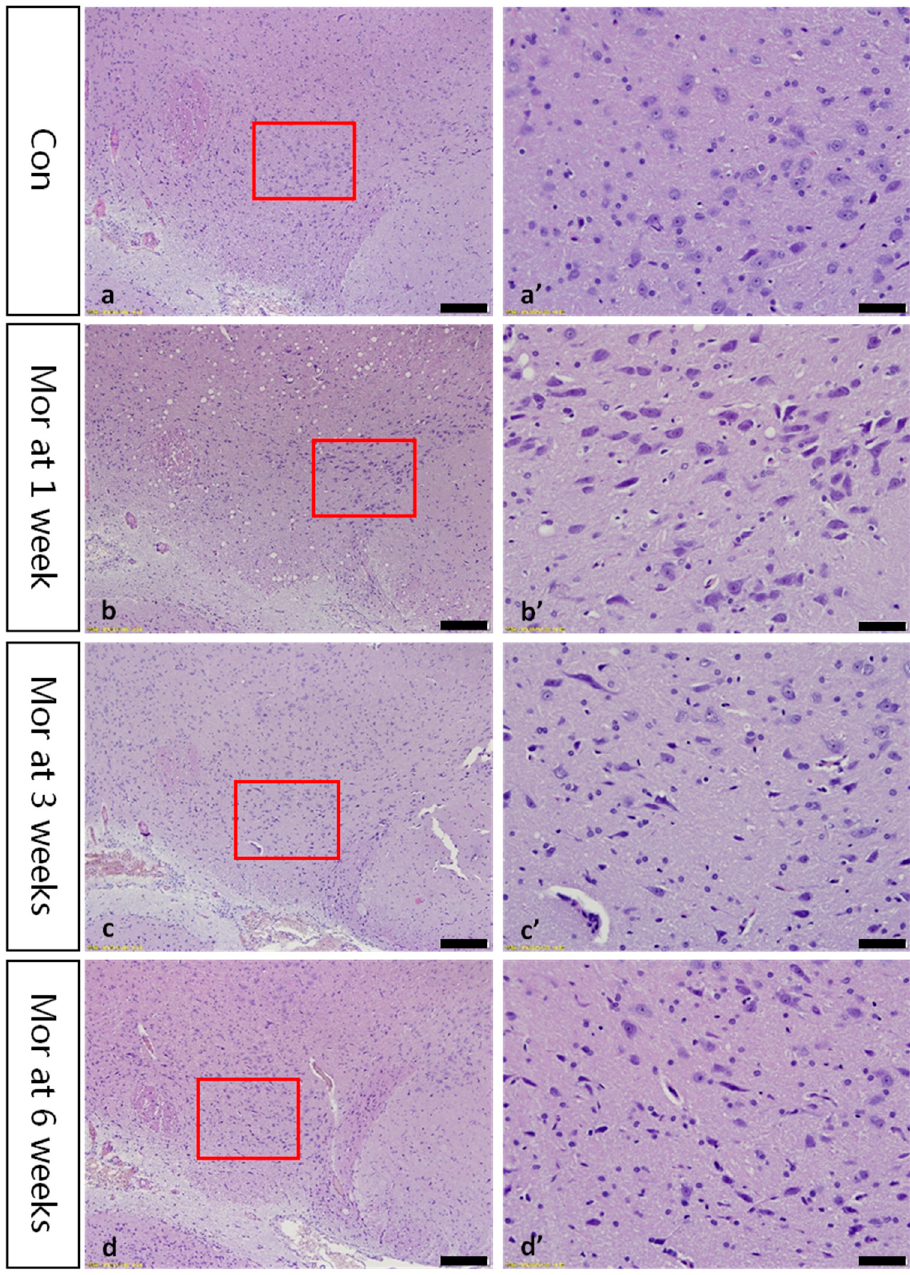
Figure 1. Thionine staining of the VTA. ( a’ – d’ ) are magnified areas of ( a – d ), respectively. With prolonged of morphine dependence, Nissl body structures are not clear and neurons are pyknotic and deeply stained. Bars = 100 μ m in ( a – d ); Bars = 50 μ m in ( a’ – d’